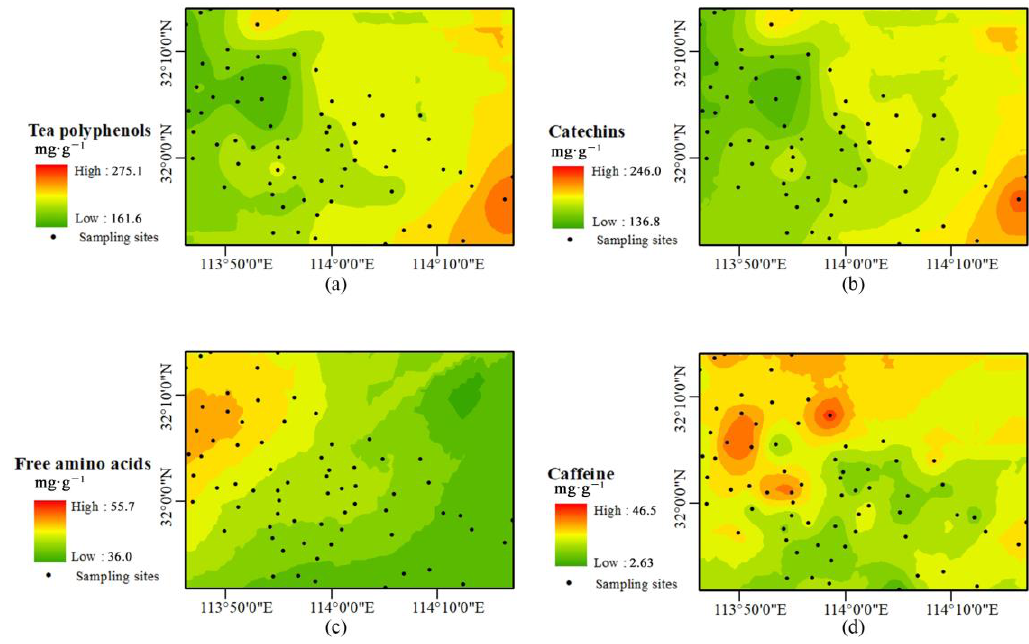
Figure 3. Distribution of main chemical component concentrations in tea. ( a ) Distribution of tea polyphenols. ( b ) Distribution of catechins in tea. ( c ) Distribution of free amino acids in tea. ( d ) Distribution of caffeine in tea.